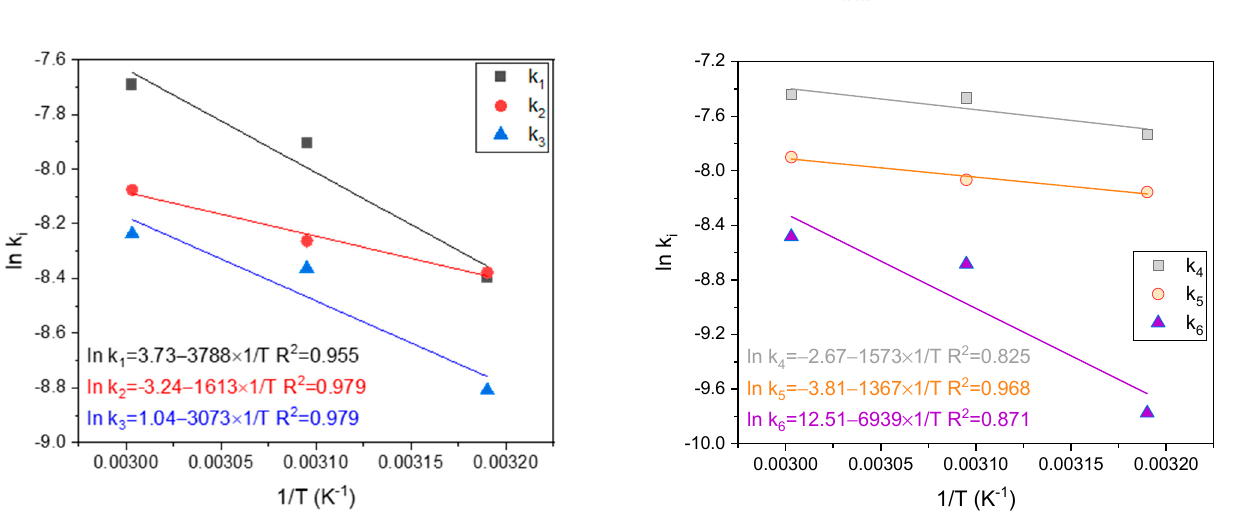
Figure 3. Estimation of ln k i 0 (point of intersection of each line on the ordinate axis) and E a / R (slope of each line) by linearising the Arrhenius equation applied to the kinetic constants of the proposed model.